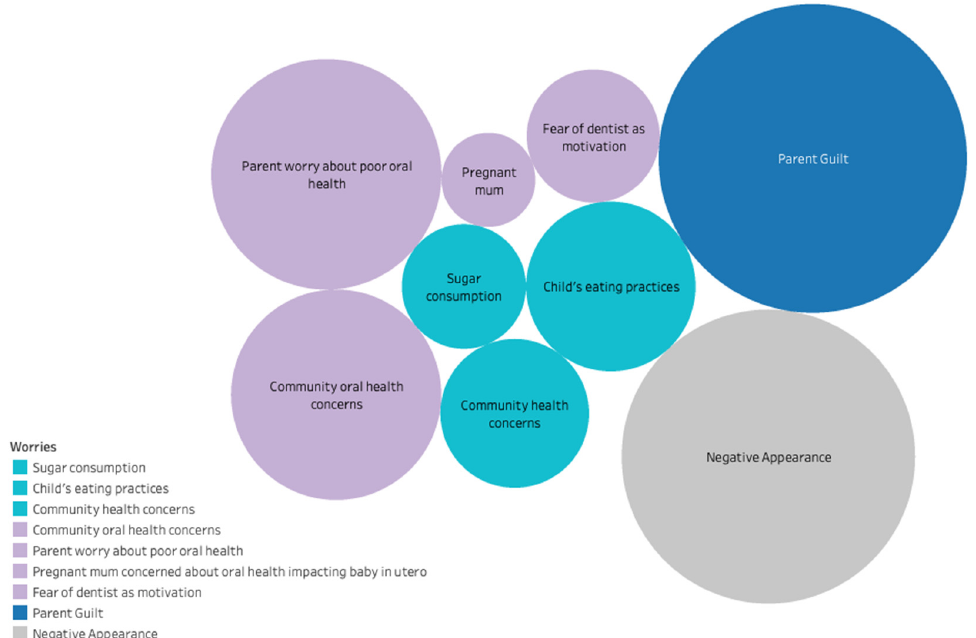
Figure 2. Parental worries contributing to intrinsic motivation. Note: The size of each bubble corresponds to the number of parents that discussed a given theme. Where more than one bubble has the same colour, the colour relates to general categories: purple with oral health, turquoise with general health, and grey with appearance.